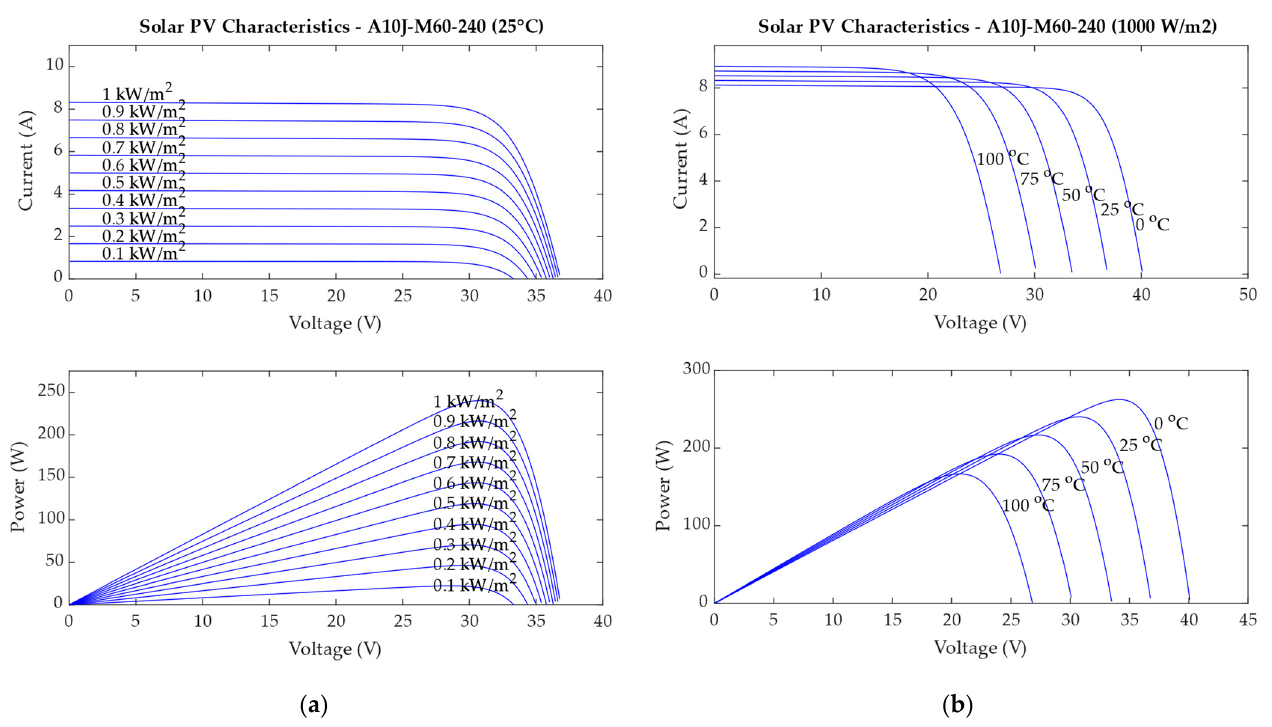
Figure 2. Current–voltage and power–voltage characteristic curves of PV A10J-M60-240: ( a ) different irradiances at 25°C; and ( b ) different temperatures at 1000 W/m 2 .